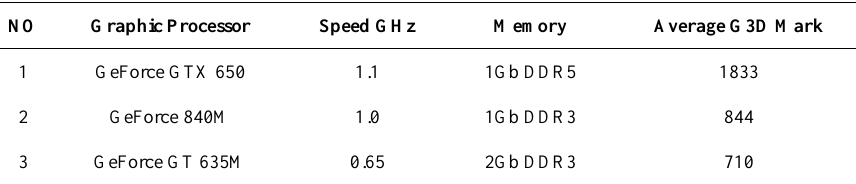
Table 2. Specifictions of graphic proccesors